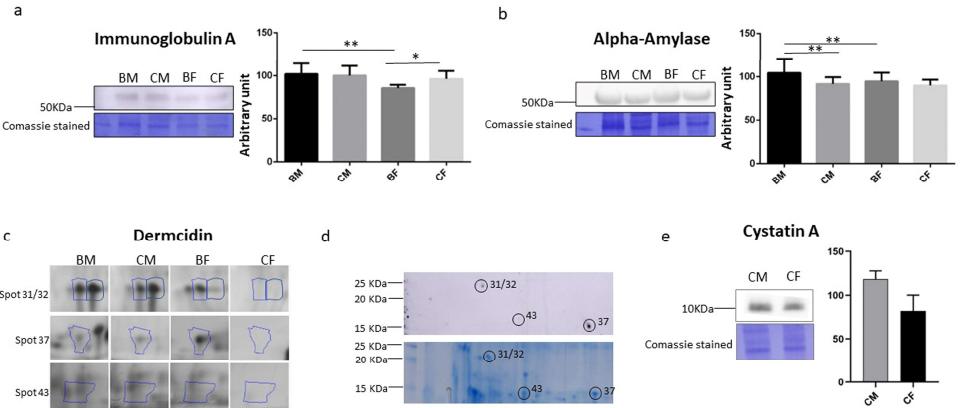
Figure 2. Validation of proteomic results. Histograms and representative immunoblot images of ( a ) Immunoglobulin A and ( b ) Alpha-Amylase in BM (basketball male group), CM (control male group), BF (basketball female group), and CF (control female group). Normalization of immunoblot was performed on Coomassie-stained PVDF membrane. The statistical analysis was carried out by two-tailed t -test, using Graphpad Prism 6 (* p < 0.05; ** p < 0.01). ( c ) Representative image of 2DE silver-stain spots, ( d ) 2DE Western blot for Dermcidin, and ( e ) Cystatin A.